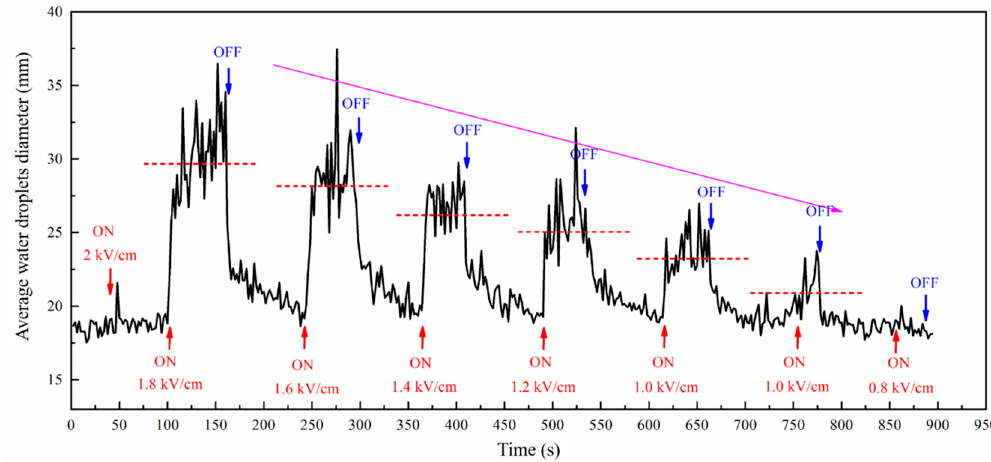
rapidly increased in a short of time once the power is on.